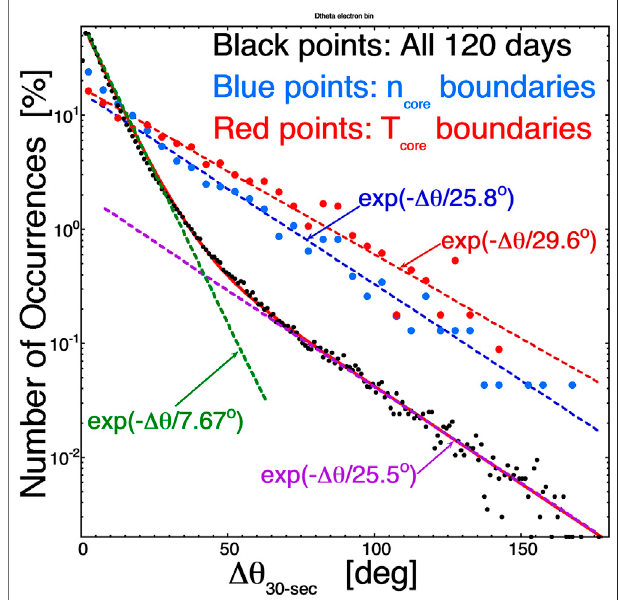
FIGURE 2 | Distributions of the 30-s change in the magnetic fi eld direction Δθ are plotted using WIND magnetic- fi eld measurements. The black points are the distribution of all values in the fi rst 120 days of 2005. The blue pointsarethe Δθ valuesatthetimesthatWINDwascrossingboundaries inthecore-electronnumberdensityandtheredpointsarethe Δθ valuesatthe times that WIND was crossing boundaries in the core-electron temperature. The exponential fi ts are described in the